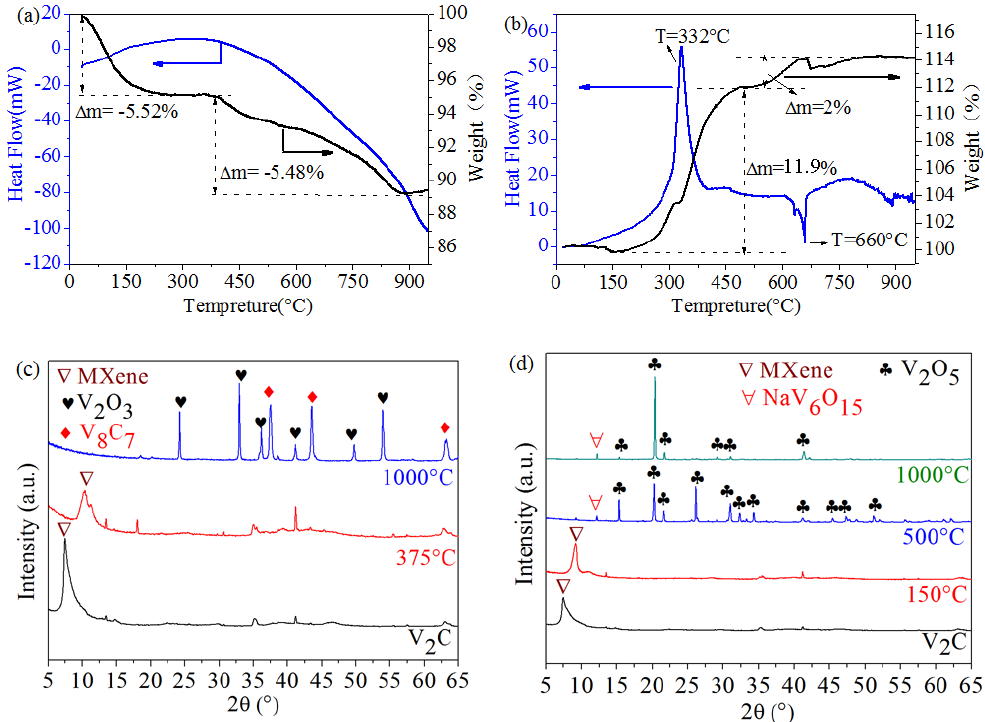
Figure 3. TG and DTA curves of V 2 C MXene in ( a ) Ar atmosphere and ( b ) air atmosphere. XRD patterns of V 2 C MXene samples after heat treatment in ( c ) Ar atmosphere and ( d ) air atmosphere.